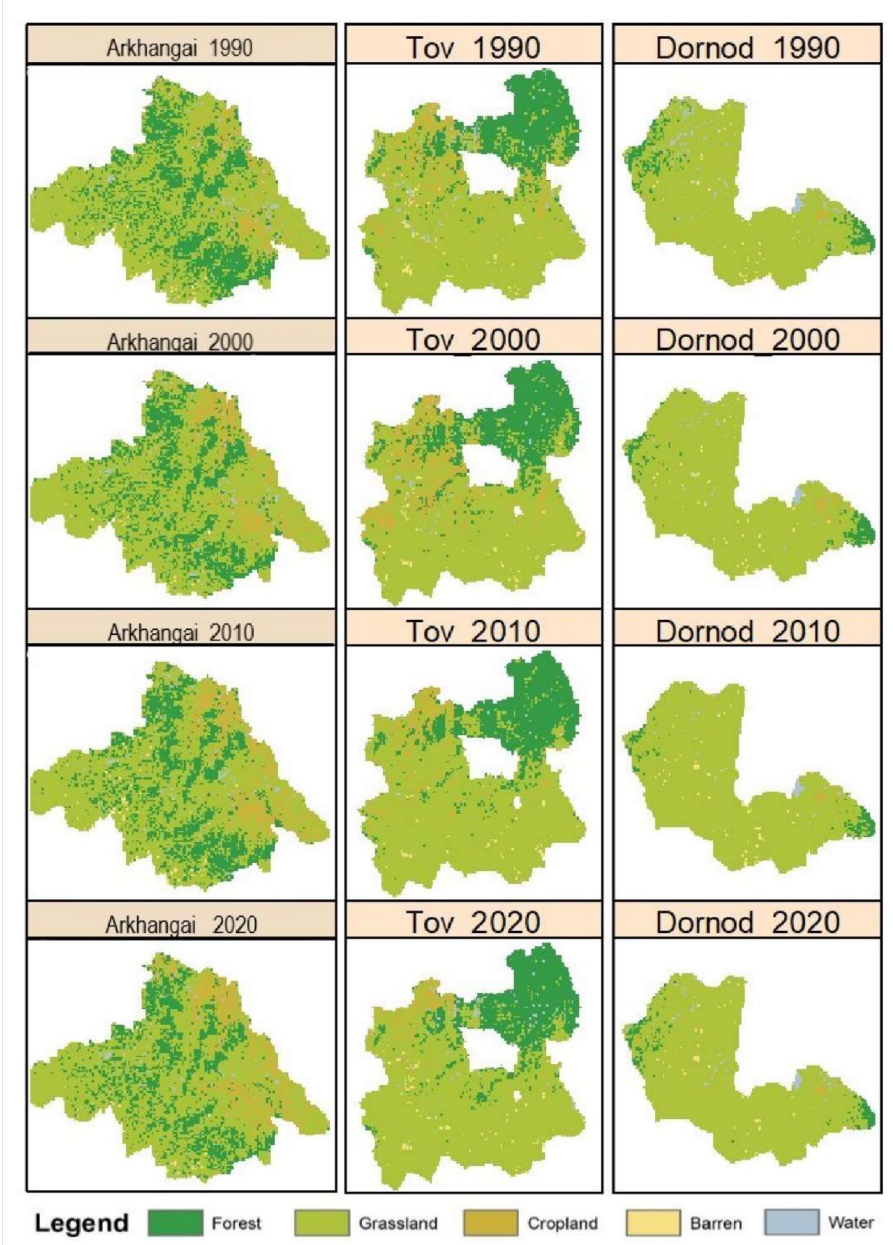
Figure A2. Classified land cover maps for the three provinces in